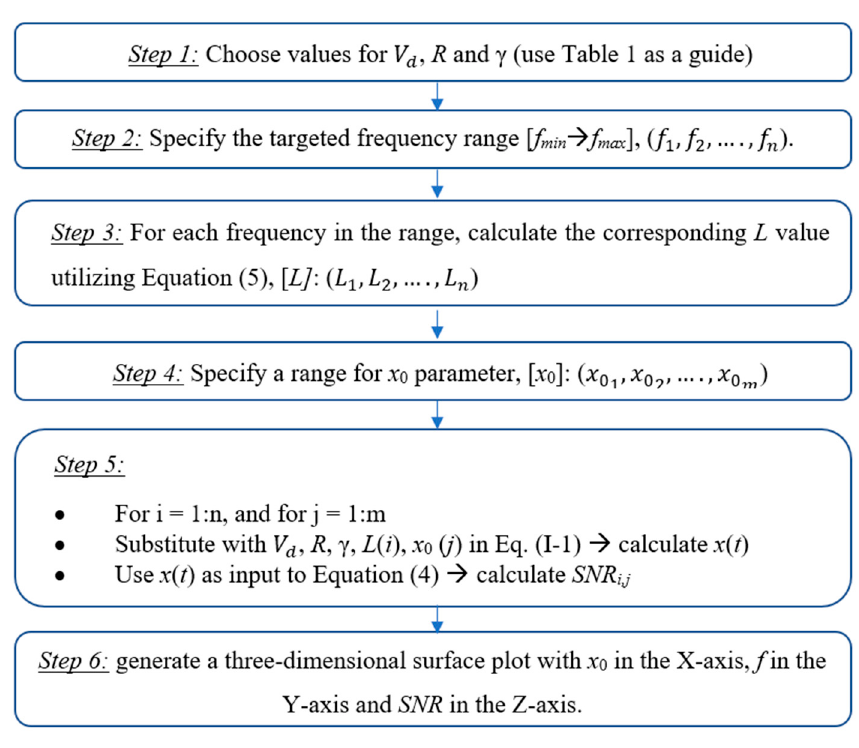
Figure 3. The FI-UPSR procedure.